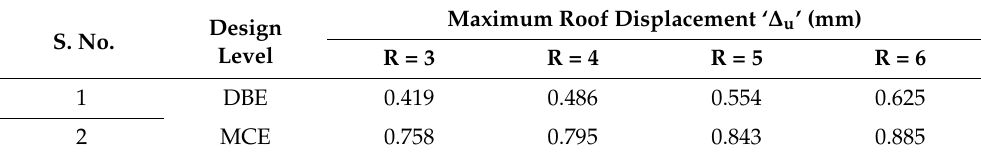
Table 11. Direct damage–loss ratio under bidirectional